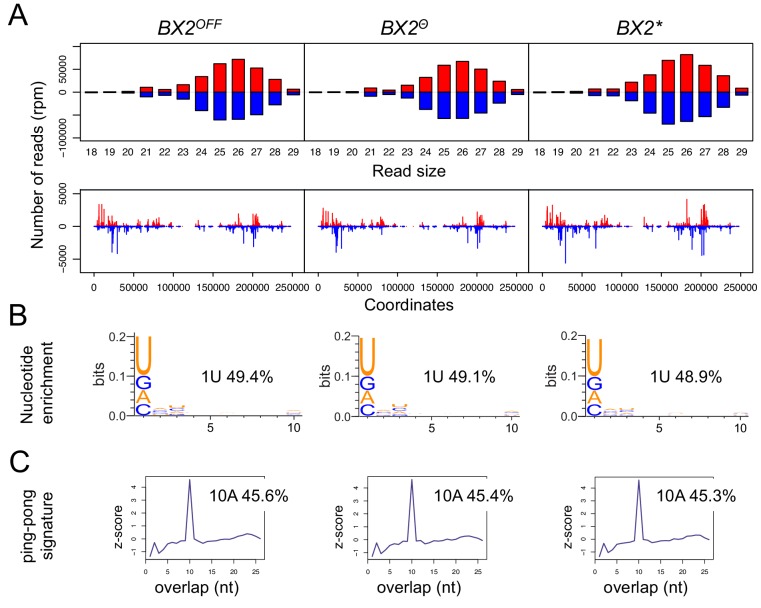
42AB piRNA production is not altered in different BX2 epigenetic contexts.(A) The size distribution and alignments of unique reads that match the 42AB piRNA cluster show that all genotypes produce similar profile of small RNAs corresponding to 42AB sequence (upper panels). Unique 23–29 nt mappers are shown on the 42AB sequence (lower panels). Positive and negative values correspond to sense (red) and antisense (blue) reads, respectively. (B) Percentage of 1U-containing small RNAs from each genotype that match 42AB sequence. (C) Relative frequency (z-score) of overlapping sense-antisense 23–29 nt RNA pairs reveals an enrichment of 10-nucleotides overlapping small RNAs, which corresponds to the ping-pong signature.